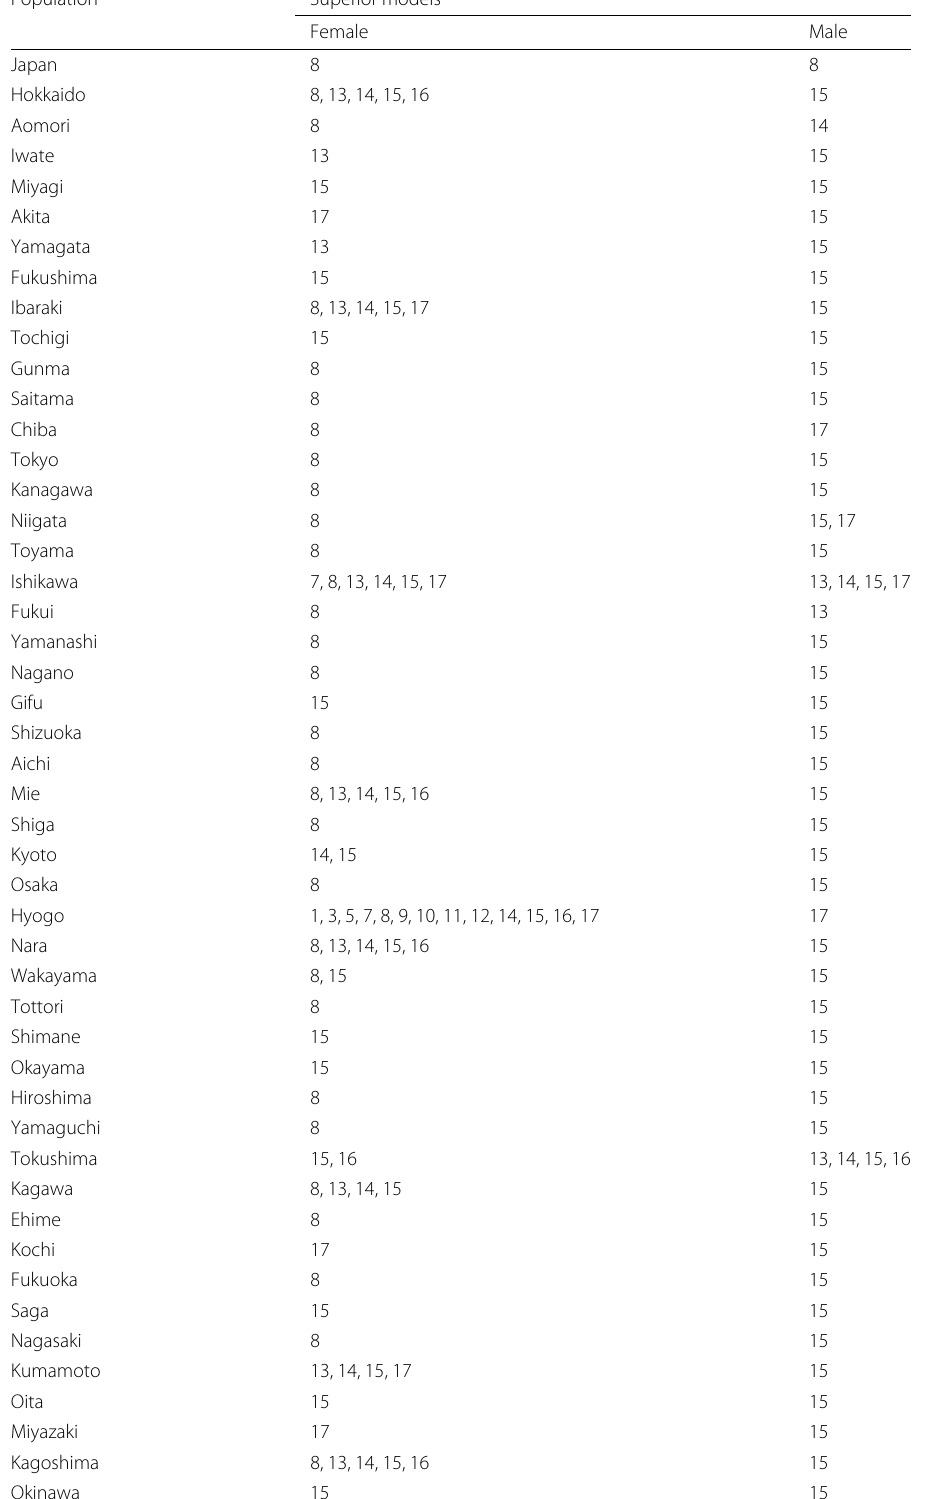
Table 4 MCS procedure using the T max,M test applied to the mean interval score in the validation set from 1996 to 2005 for forecasting the Japanese female and male national and sub-national mortality rates for ages between 60 and 100+ Population Superior